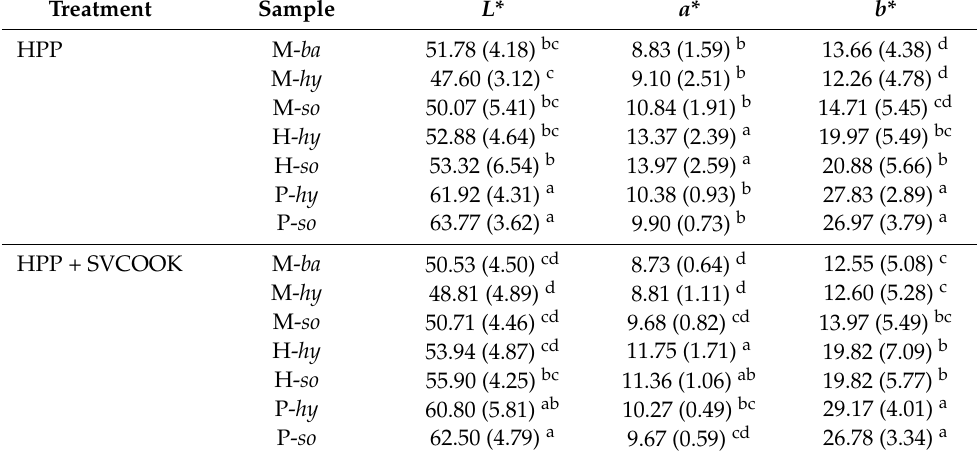
Table 2. Color parameters of samples treated by HPP or HPP + SVCOOK according to protein matrix (M: meat-based patty; H: hybrid patty; P: plant-based patty) and fat replacement ( ba : backfat; hy : hydro-gelled emulsion; so : soya emulsion). Values are expressed as mean (standard deviation). Treatment Sample L * a * b * HPP M- ba 51.78 (4.18) bc M- hy M- so